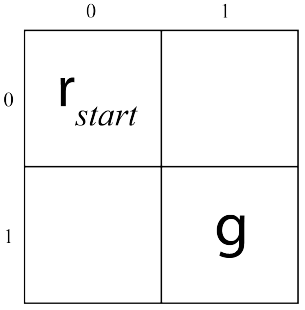
Figure 6. Schema of a 2 × 2 world. r start depicts the robot in the ( 0,0 ) cell, while g indicates the goal cell. The planning goal is reached when the current position state contains the location ( 1,1 )